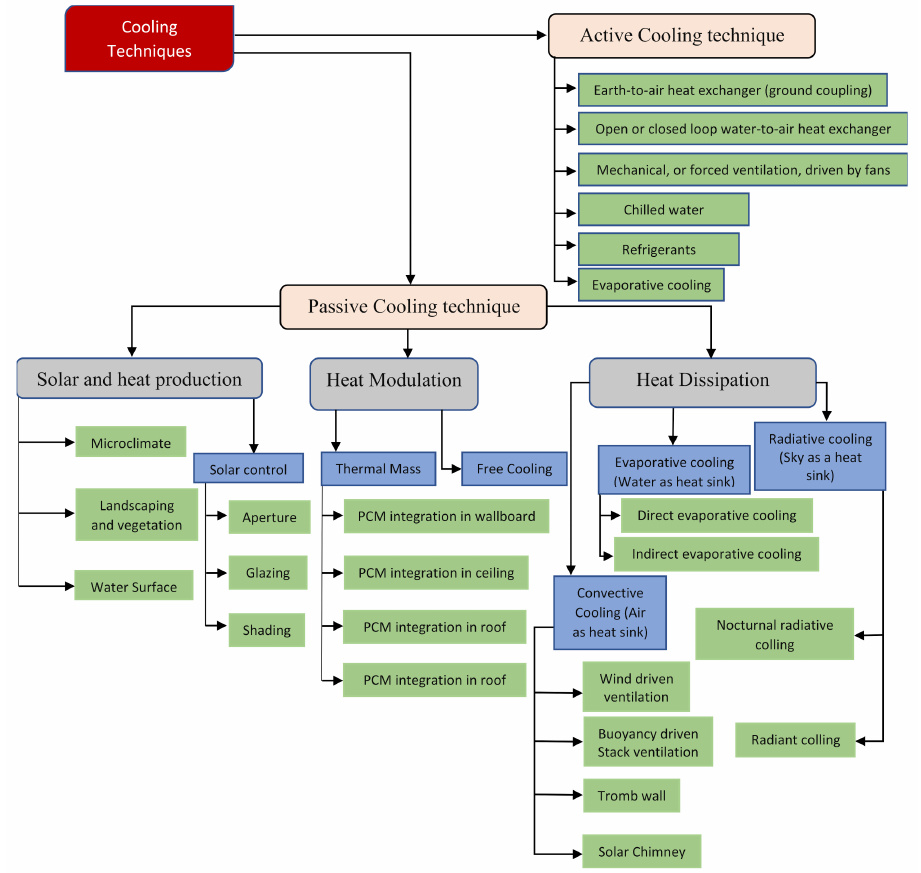
Figure 2. Various active and passive cooling techniques